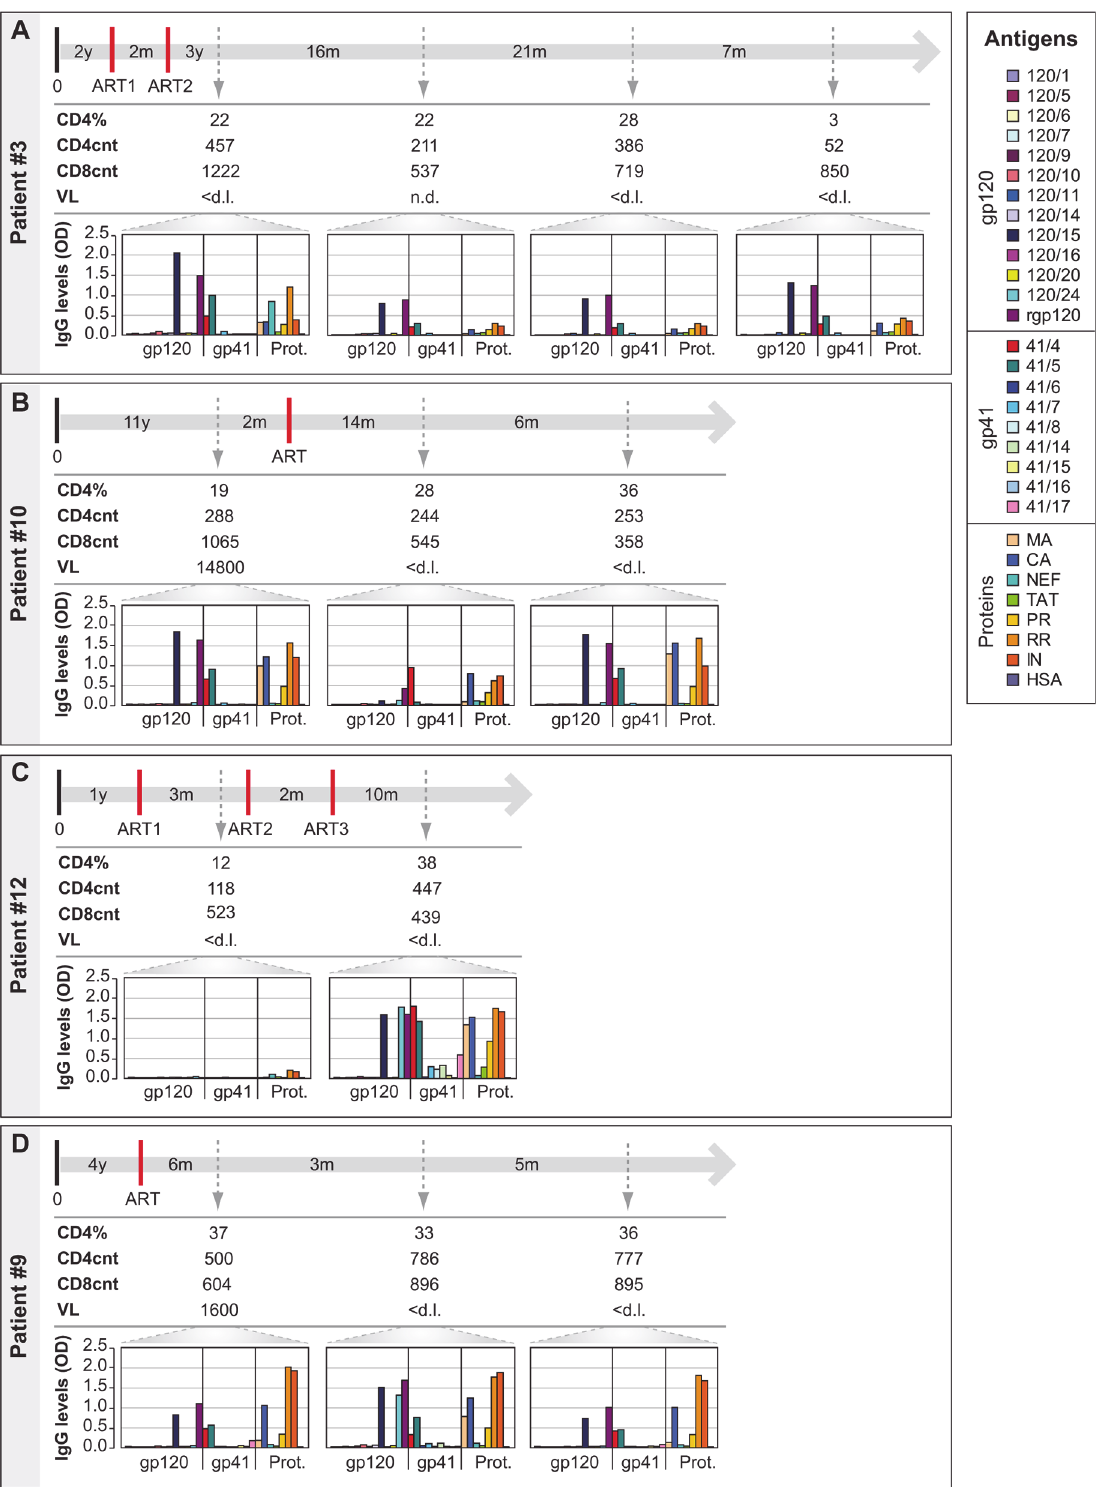
Fig 5. Monitoring of CD4+ and CD8+ T-cell counts, viral loads and IgG reactivity profiles to HIV-1 clade C-derived proteins and peptides during infection and treatment. Displayed are percentages of CD4+ T-cells, CD4+ and CD8+ T-cell counts, viral loads and levels of IgG antibodies to HIV-1 clade C-derived proteins and peptides (the box shows color codes of antigens and peptides) over time (top line) for patients with variable antibody reactivity profiles (A: patient #3; B: patient #10; C: patient #12; D: patient #9). Abbreviations: 0, 1 st positive test / 1 st visit; ART, antiretroviral therapy; ART1, ART2 and